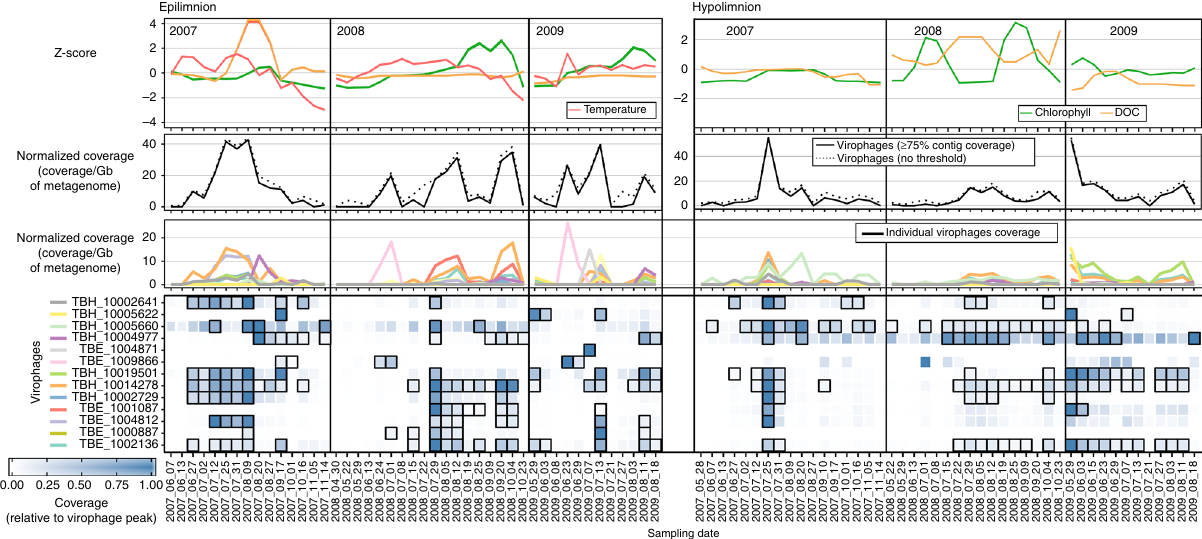
Fig. 5 Virophage abundance, chlorophyll a concentration, tempreature, and dissolved organic carbon in Trout Bog Lake Epi- and Hypolimnion. Chlorophyll a , temperature, and DOC levels are displayed as Z-score to highlight their variation across each data set. Temperature for Trout Bog Lake Hypolimnion was stable at 4.6°C (standard deviation: ± 0.7 °C). Virophage abundance are based on the mapping of metagenomic reads to virophage contigs. Individual virophage coverage is plotted in the third panel and virophages are highlighted with a black outline in the heatmap (fourth panel) when > 75% of the contig is